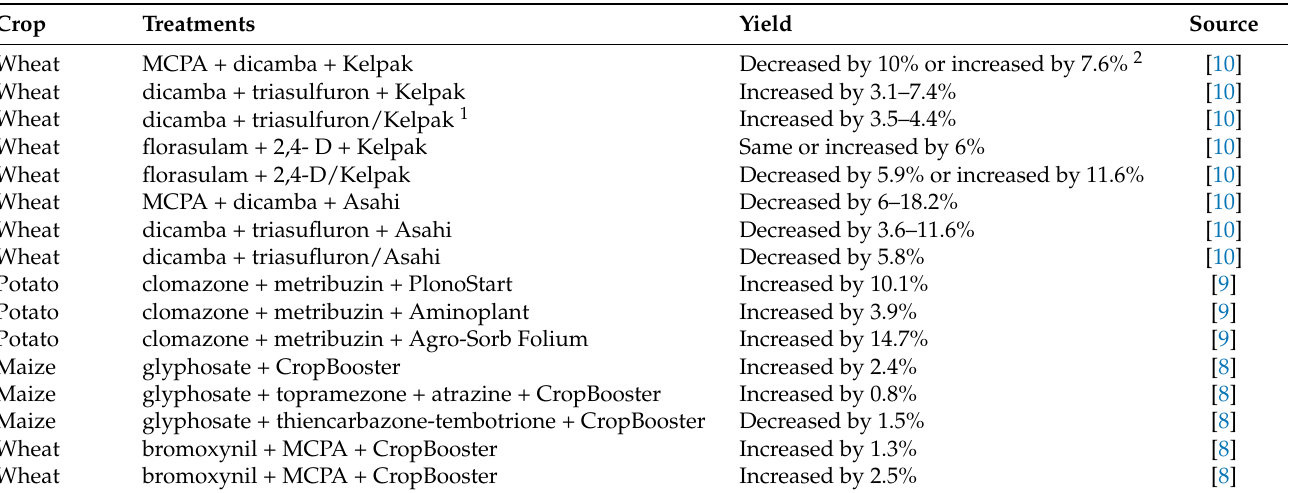
Table 2. Effects of the combined use of biostimulants and herbicides on the yield of different crops compared to the use of the respective herbicides alone (without